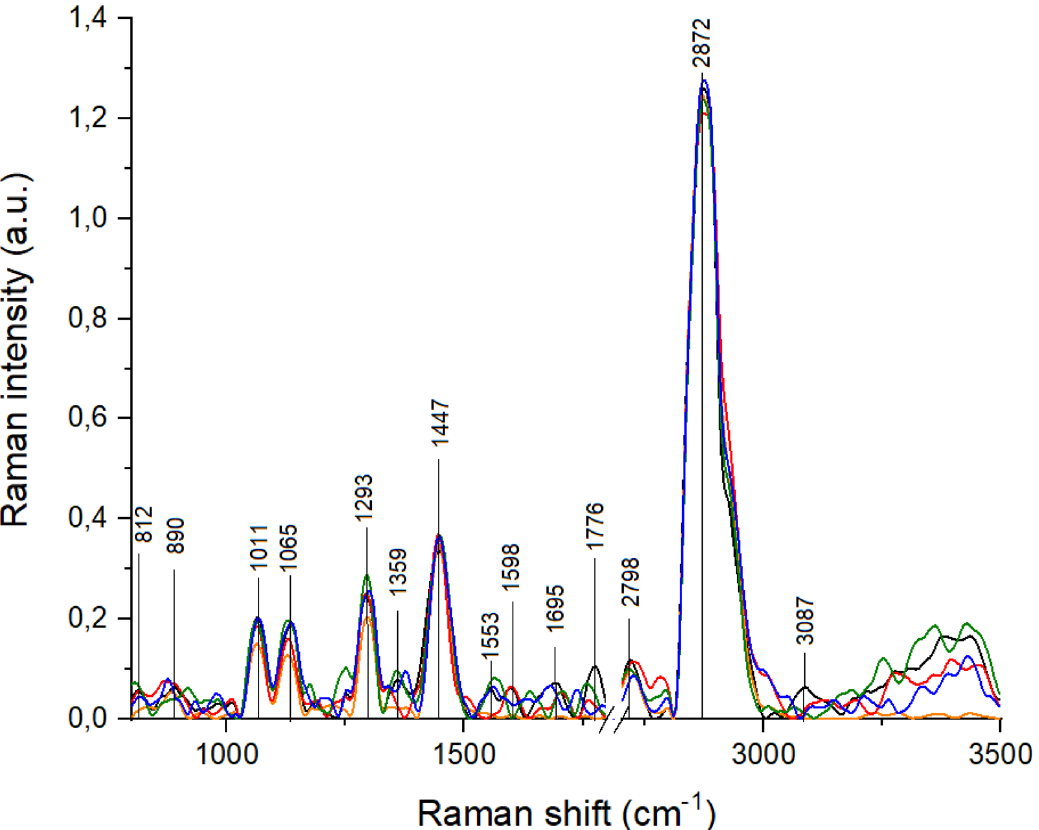
Figure 1. Raman spectra of samples: control (black spectrum); atrophic endometrium (orange spectrum); complex atypical hyperplasia (red spectrum); endometrial polyp (green spectrum); endometrioid adenocarcinoma (blue